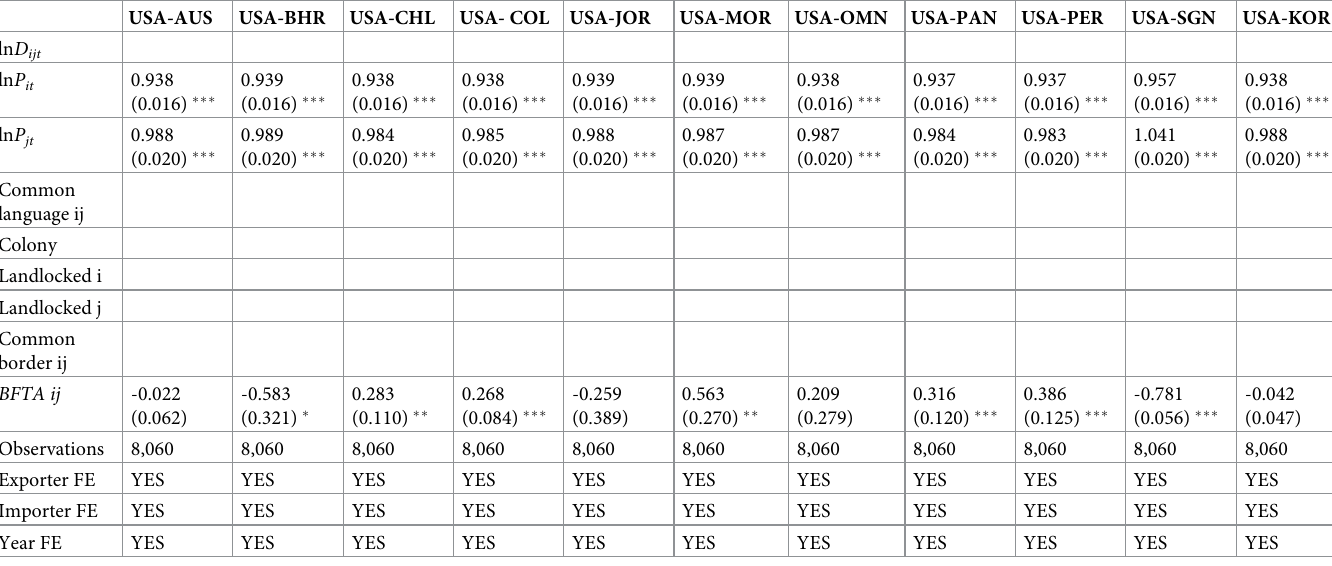
Table 6. PPML estimation results with country and time fixed effects for the case of the United States as an exporter. USA-AUS